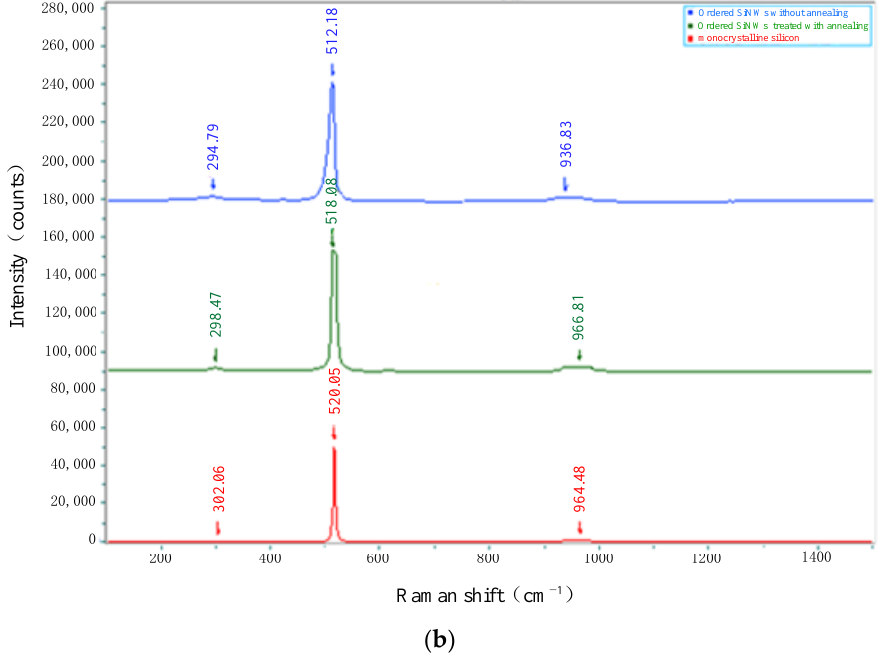
Figure 5. The comparison of Raman spectral curves of SiNWs fabricated by two methods: ( a ) SiNWs fabricated with randomly distributed Ag film; ( b ) SiNWs fabricated with the spatially ordered mesh Au film.